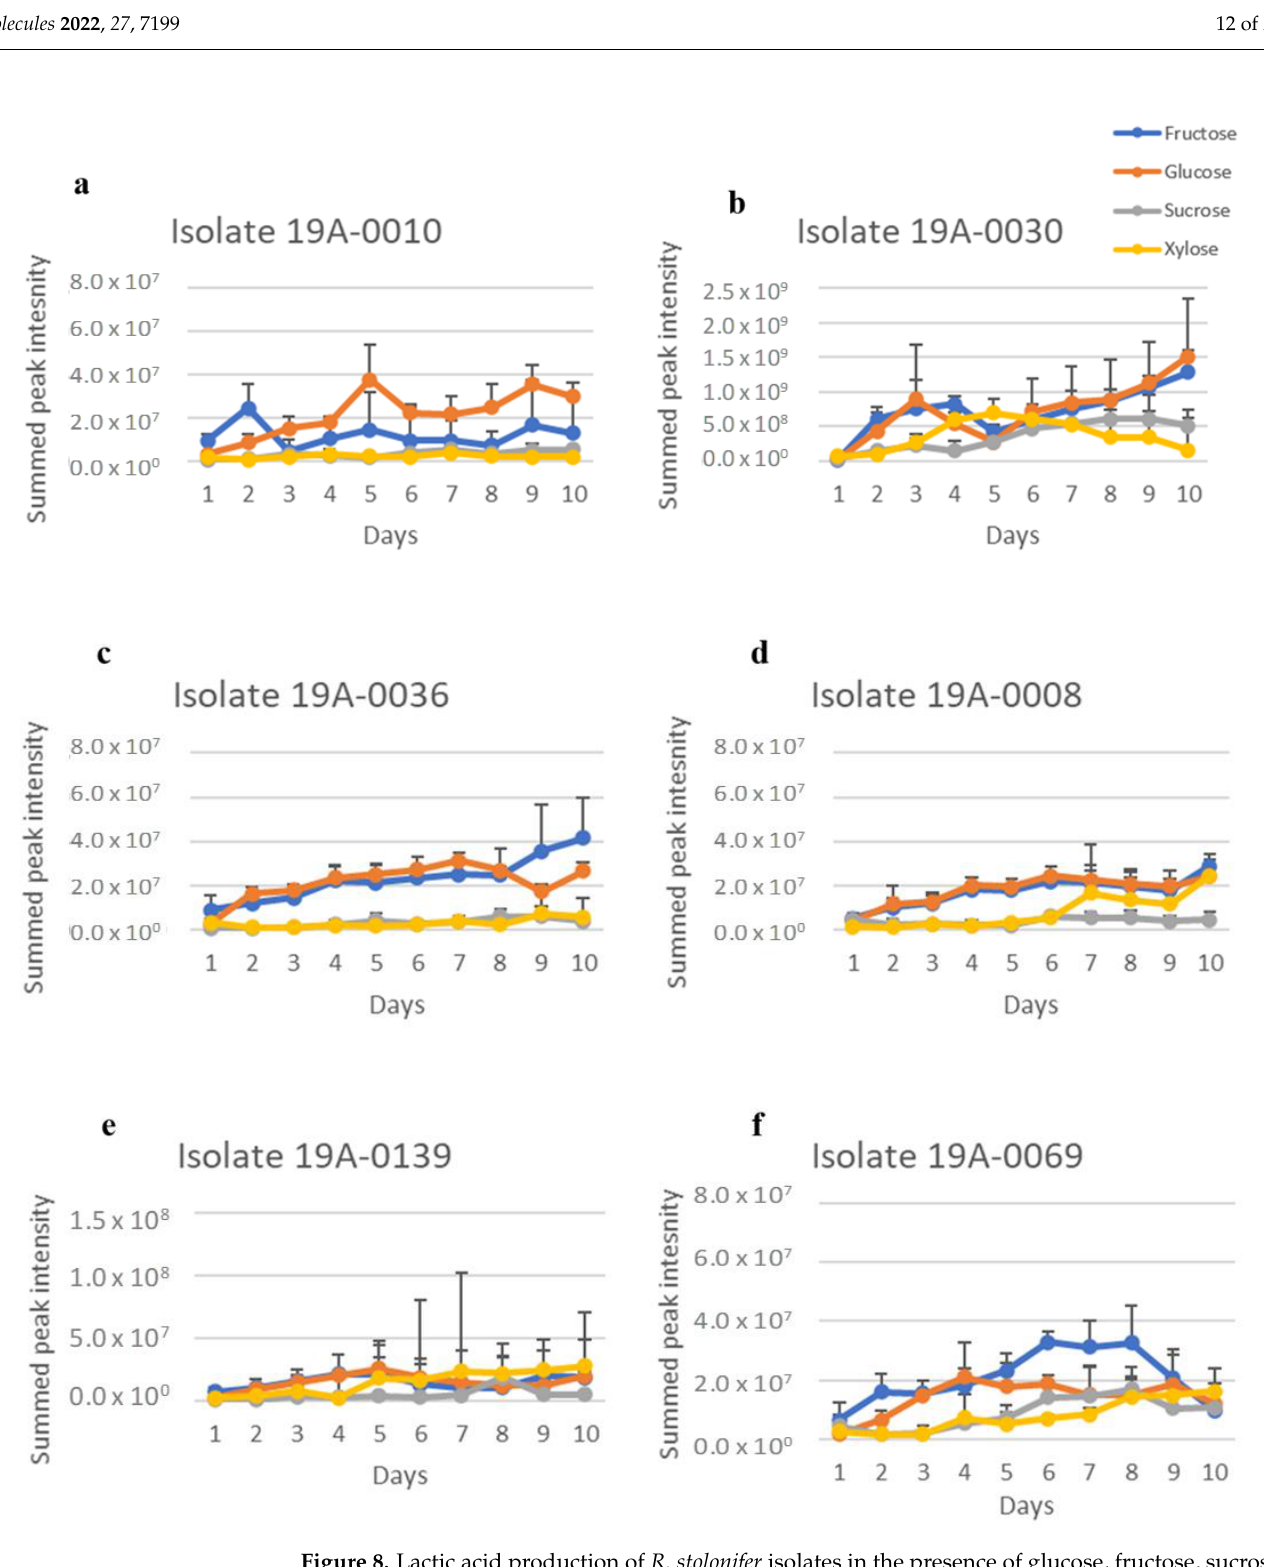
Figure 8. Lactic acid production of R. stolonifer isolates in the presence of glucose, fructose, sucrose, or xylose, along with NH 4 (SO 4 ) 2 as a nitrogen source. Data presented are the relative concentration of lactic acid (as determined from NMR) with standard deviation (error bars) n = 3. ( a ) Isolate 19A – 0010, ( b ) isolate 19A – 0030, ( c ) isolate 19A – 0036, ( d ) isolate 19A – 0008, ( e ) isolate 19A – 0139, ( f ) isolate 19A – 0069